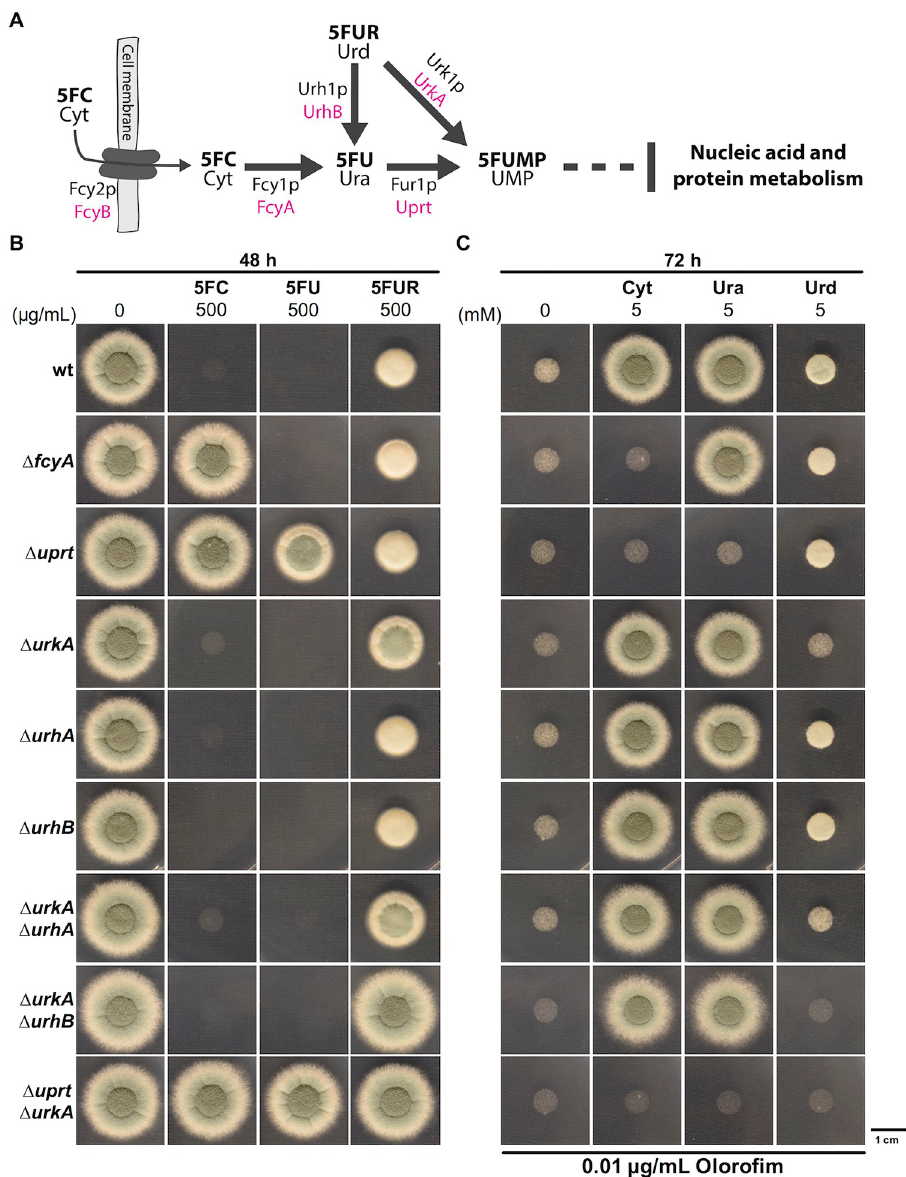
Fig 1. UrhB and UrkA mediate the hydrolysis and phosphorylation of 5FUR/uridine. (A) Scheme illustrating proteins involved in 5FC uptake and pyrimidine salvage pathway based metabolization of fluoropyrimidines in yeast (black) and A . fumigatus (magenta). (B) The role of uridine nucleosidase and uridine kinase encoding genes was determined by susceptibility testing. (C) Resistance analysis was complemented with a reversal assay studying the contribution of enzymes in the metabolization of nucleobases cytosine (Cyt) and uracil (Ura) as well as the nucleoside uridine (Urd) during de novo pyrimidine biosynthesis inhibition.